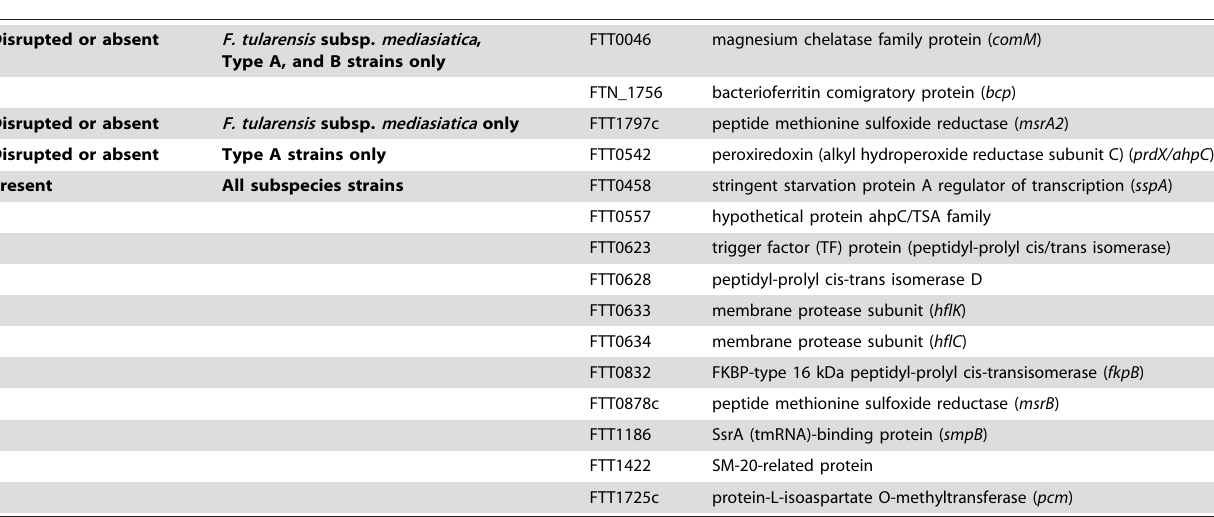
Table 5. Phylogenetic Differentiation Associated with Gain and Loss of Genes with Sequence Similarity to T4SS